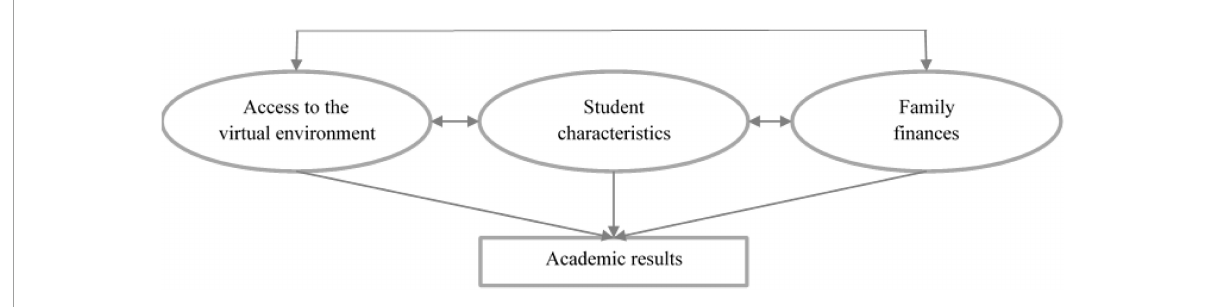
FIGURE1 Causal diagram showing the relationship between variables (technological, economic, student characteristics, and academic results).